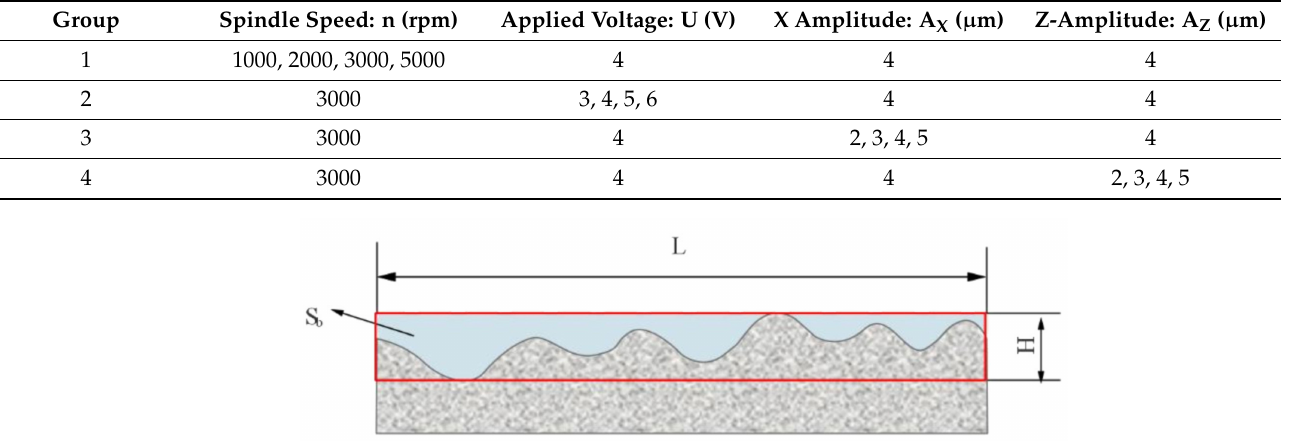
Figure 4. Method for calculating form